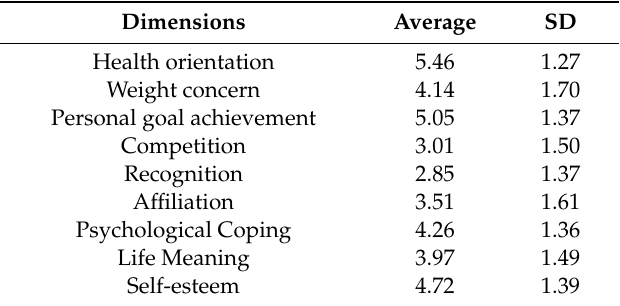
Table 2. Basic descriptive statistics, n =